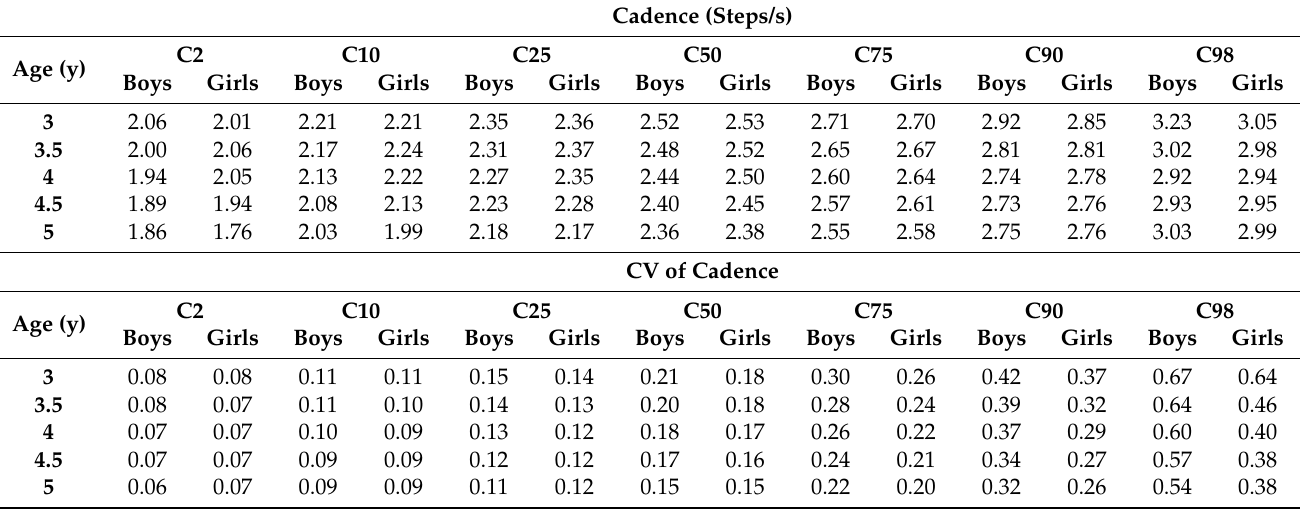
Table 2. Centiles of cadence and CV by age and